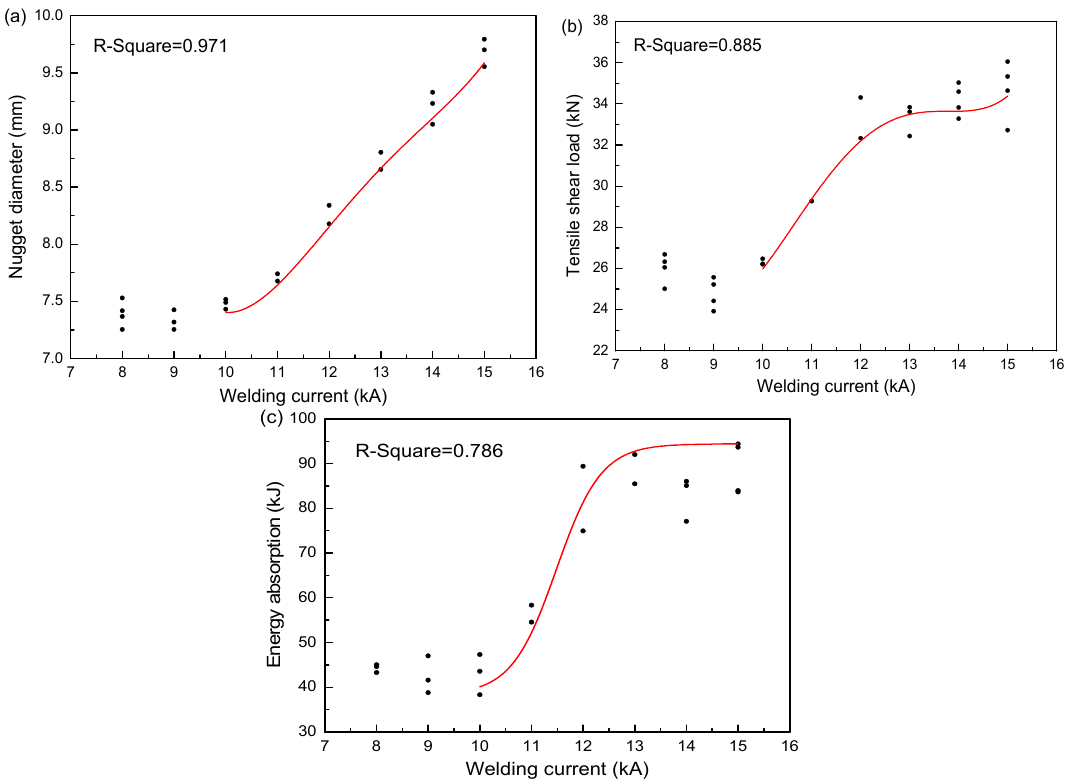
Figure 3. Effect of welding current: ( a ) Nugget diameter vs. welding current; ( b ) Tensile-shear load vs. welding current; ( c ) Energy absorption vs. welding current.